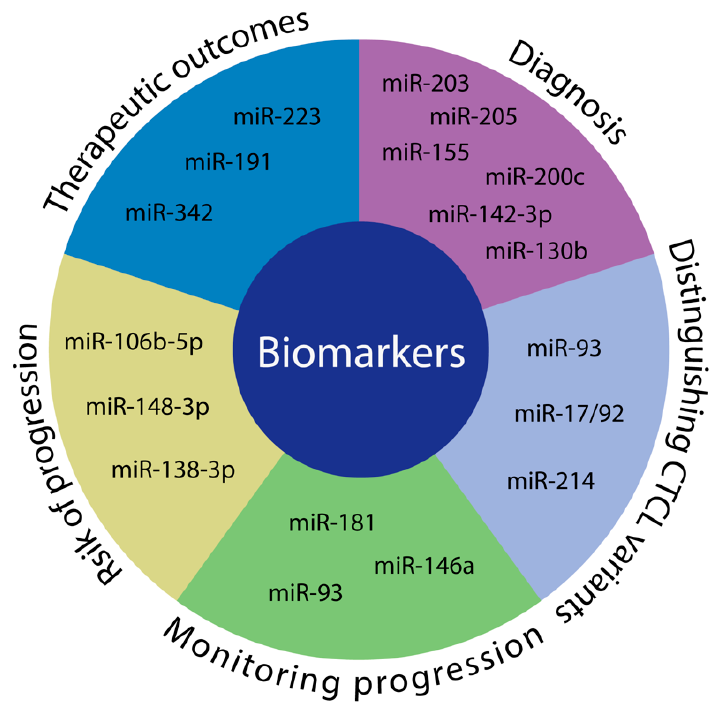
Figure 3. miRs as diagnostic, prognostic and predictive biomarkers. miRs possess an important clinical potential to be used as biomarkers. In CTCL, evidence suggests that they may be able to discern CTCL from benign inflammatory dermatoses (diagnosis) as well as distinguish between subtypes of CTCL (distinguishing CTCL variants). Furthermore, miRs may be able to stratify patients into low vs. high risk of progression groups (risk of progression) and could be used to monitor progression in patients (monitoring progression). Additionally, expression of certain miRs may be able to predict treatment outcomes (therapeutic outcomes).